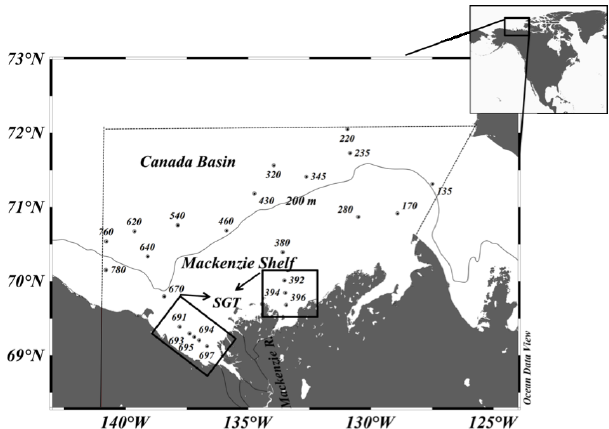
Fig. 1. Sampling map. See Table 1 for detailed sampling informa- Fig. 1. S ampling map. See Table 1 for detailed sampling information for each station. Solid line 4 tion for each station. Solid line is the 200m isobath. Dashed line is the 200-m isobath. Dashed line designates the area for which CO photoproduction rates were 5 designates the area for which CO photoproduction rates were mod- modeled. This map was constructed using the online software of Ocean Data View (R. Schlitzer, 6 eled. This map was constructed using the online software of Ocean 2010, unpublished data, http://odv.awi.de). 7 Data View (R. Schlitzer, 2010, unpublished data,